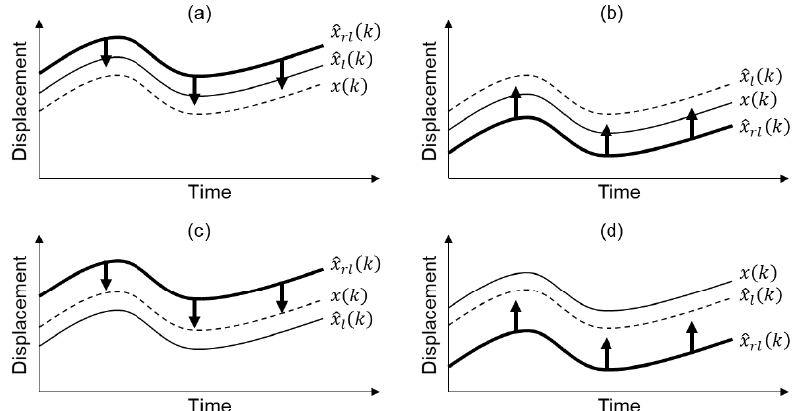
( k ) , in case of ( a ) e r ( k ) ≥ 0 and e a ( k ) ≥ 0, Figure 2. The overall concept of how to determine the sign of e r Figure 2. The overall concept of how to determine the sign of 𝑒 𝑙𝑟 (𝑘) , in case of ( a ) 𝑒 𝑙𝑟 (𝑘) ≥ 0 and l l l ( k ) < 0 and e a ( k ) < 0, ( c ) e r ( k ) ≥ 0 and e a ( k ) < 0, and ( d ) e r ( k ) < 0 and e a ( k ) ≥ 0. The thick black ( b ) e r 𝑒 𝑙𝑎 (𝑘) ≥ 0 , ( b ) 𝑒 𝑙𝑟 (𝑘) < 0 and 𝑒 𝑙𝑎 (𝑘) < 0 , ( c ) 𝑒 𝑙𝑟 (𝑘) ≥ 0 and 𝑒 𝑙𝑎 (𝑘) < 0 , and ( d ) 𝑒 𝑙𝑟 (𝑘) < 0 and l l l l l l arrows indicate the direction of 𝑒 𝑙𝑎 (𝑘) ≥ 0 . The thick black arrows indicate the direction of correction.